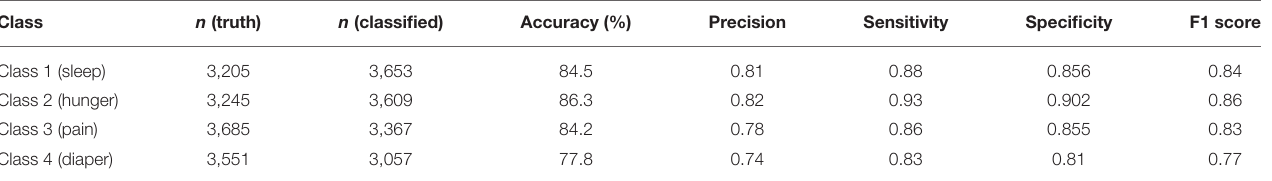
TABLE 13 | Evaluation metrics for the VGG16 model.